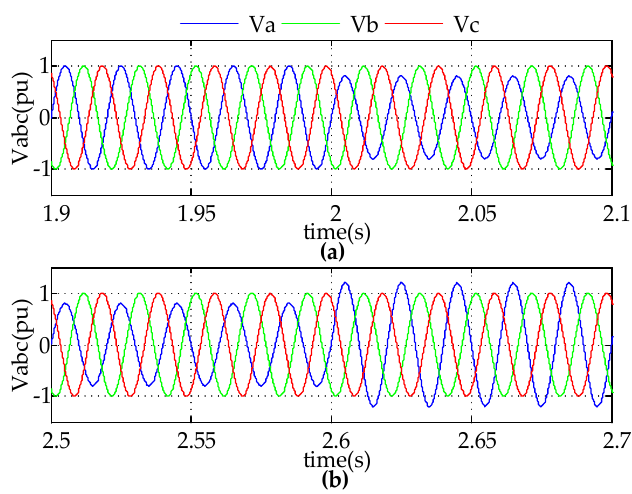
GSC Figure 1. Structure scheme of doubly fed induction generator (DFIG) system with IDA-PBC method.